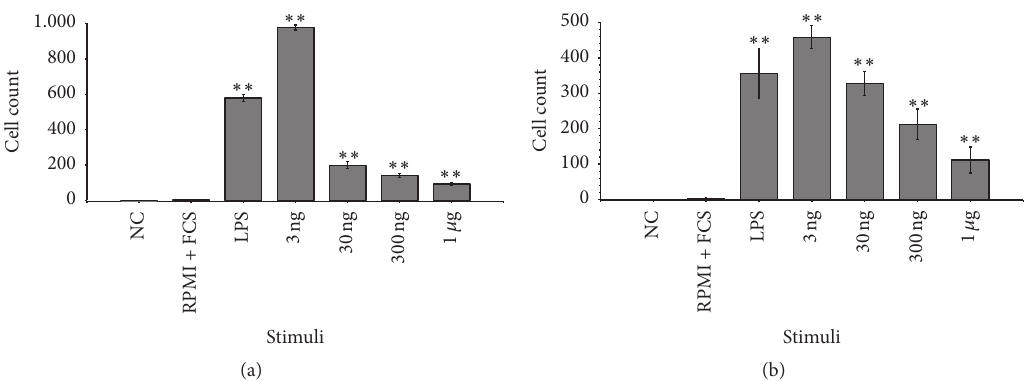
Figure7:ChemotacticactivityoftheTrx-lpfrom S.ratti (a)and T.suis (b)formonocyticTHP-1cells.Thechemotacticactivityofbothproteins for THP-1 cells was investigated by using Boyden chambers. Different concentrations of the Trx-lps were added to the lower compartment of the chemotactic chambers. Protein concentrations per 100 𝜇 L of 3 ng, 30 ng, 300 ng, and 1 𝜇 g showed SrTrx-lp and TsTrx-lp have the greatest chemotactic activity at 3 ng. Chemotaxis buffer (NC) and THP-1 media (RPMI + FCS) were included as negative control (random cell migration), while LPS was used as positive control. All used Trx-lp concentrations led to significant higher cell migration than the negative controls ( ∗∗ 𝑃 < 0.01